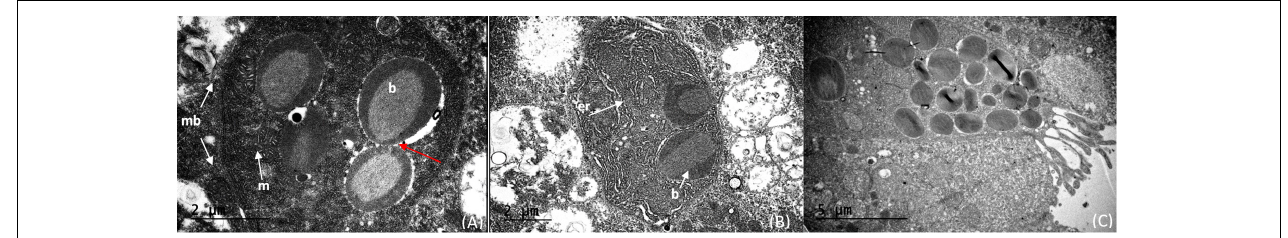
FIGURE 5 | Cristae of the mitochondria (m) distinctly shown compared to the intracellular microbes (b) within the cell (membrane—mb). The cells on the right appear to have just divided (red arrow) (A) . Intracellular microbes (b) with endoplasmic reticulum (er) distributed throughout the cell (B) . Bacteria within the light organ suggest intracellular to extracellular excretion activity of the light organ (C)